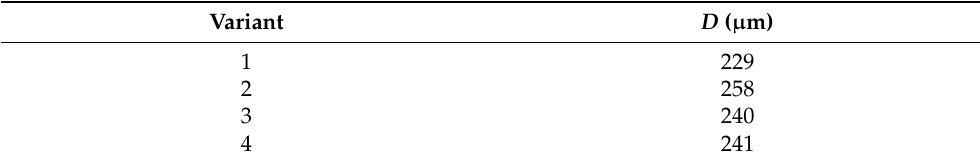
Figure 13. Microstructure consisting of allotriomorphic ferrite, pearlite and acicular ferrite in the undeformed region A: ( left ) sample V1 and ( right ) sample V3. The original austenitic grain boundary is marked in red. Table 6. Average austenitic grain size values at heating temperature.